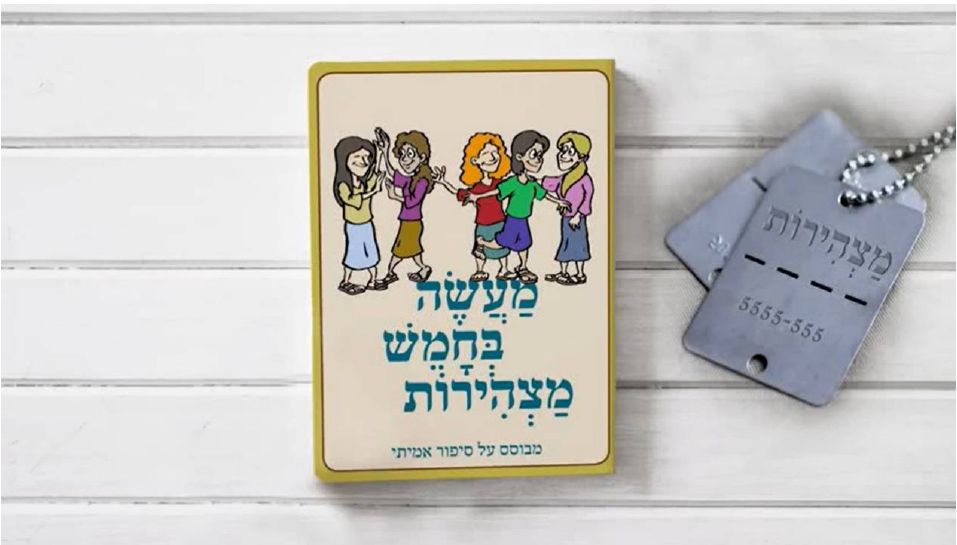
Figure 5. ‘A tale of five declarers’ (January 2019). [Hebrew wording on the book cover depicted in the picture: “A tale of five declarers; Based on a true story”; On the military identity disc: “Declarers”] (Supplementary Materials).